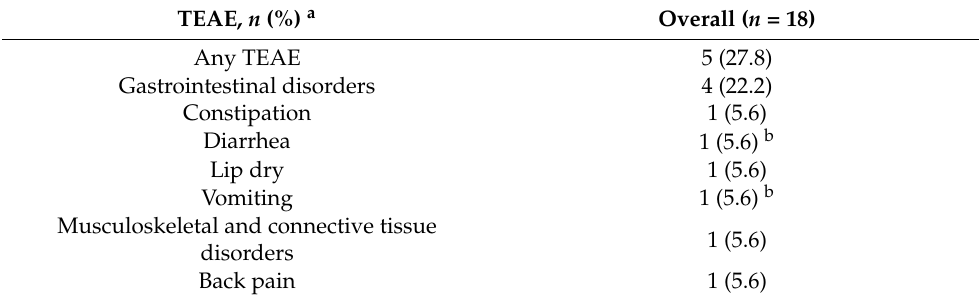
Table 2. Treatment-emergent adverse events in the full analysis set.